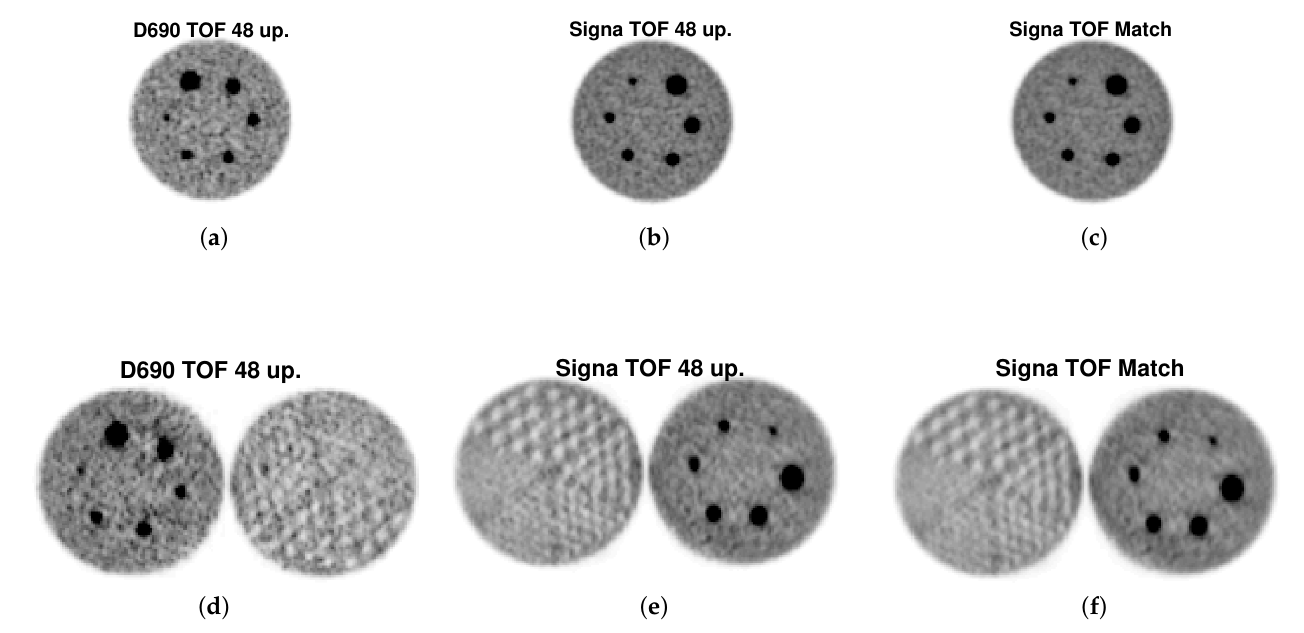
Figure 4. TOF Reconstructions of the phantoms in different conditions. Upper: Single acquisitions. Lower: Double acquisition, HCR only for SIGNA shown for clarity. Left ( a , d ): D690 acquisitions, 48 updates. Center ( b , e ): SIGNA acquisitions, 48 updates. Right ( c , f ): SIGNA acquisitions, 32 updates according to the proposed